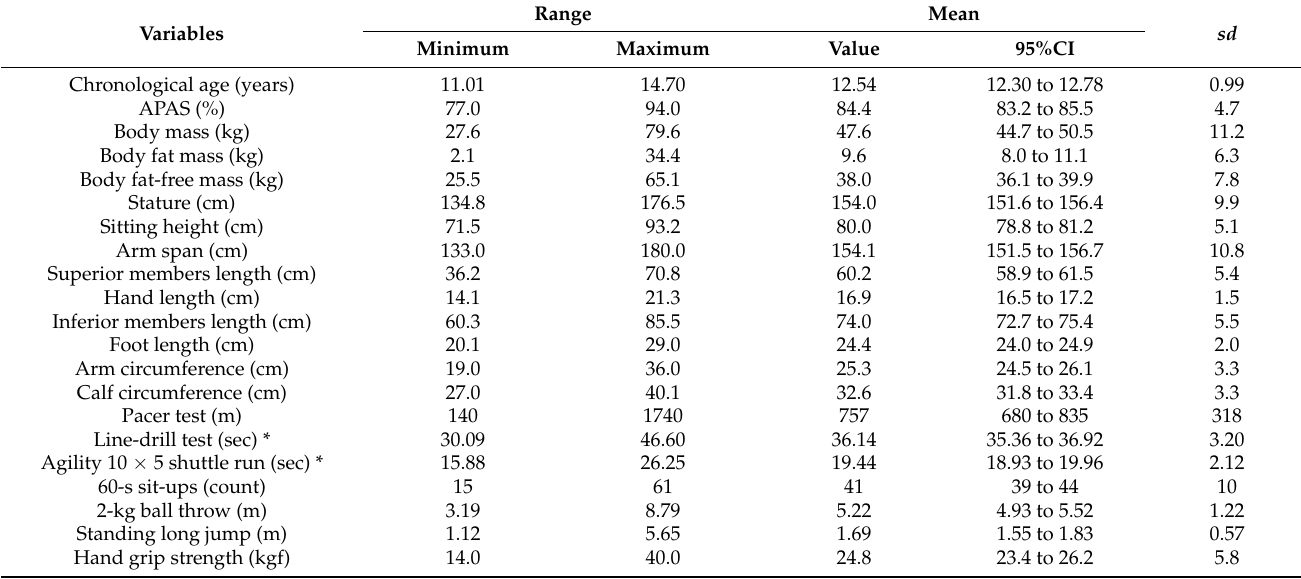
Table 1. Descriptive statistics for the total sample ( n =